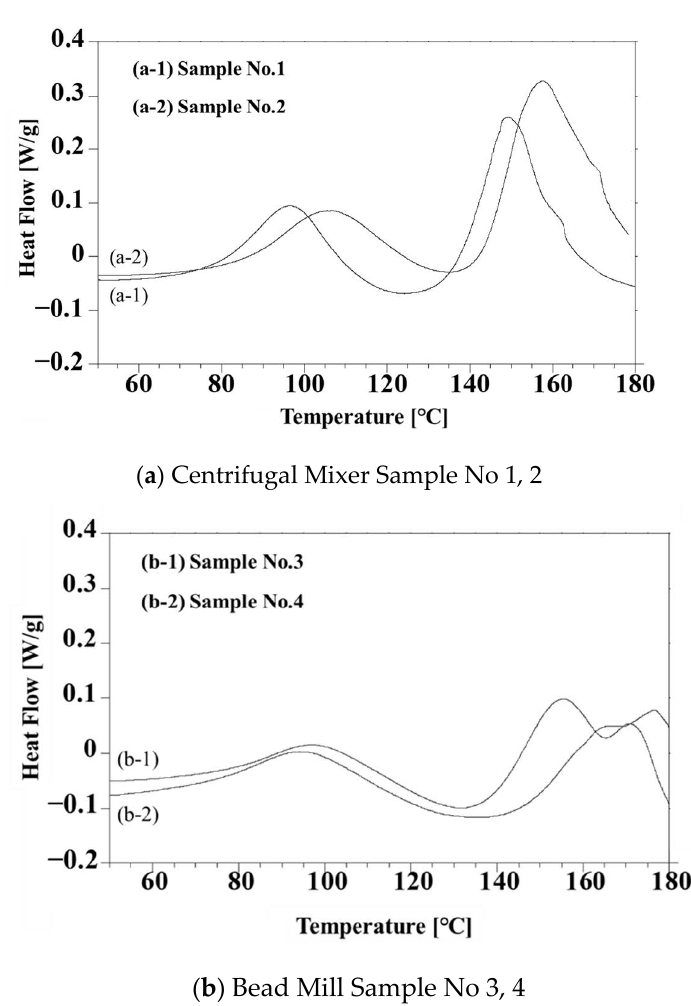
Figure 6. DSC data obtained from ( a ) Samples 1 and 2 and ( b ) Samples 3 and 4. Samples were processed using peroxides.